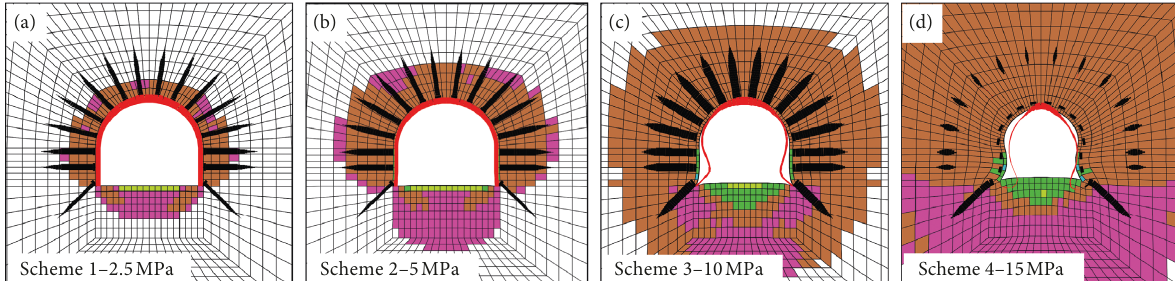
Figure 5: Surrounding rock plastic zones and supporting structure inner force diagrams of (a) Schemes 1, (b) Schemes 2, (c) Schemes 3, and (d) Schemes 4 at the 50th day.